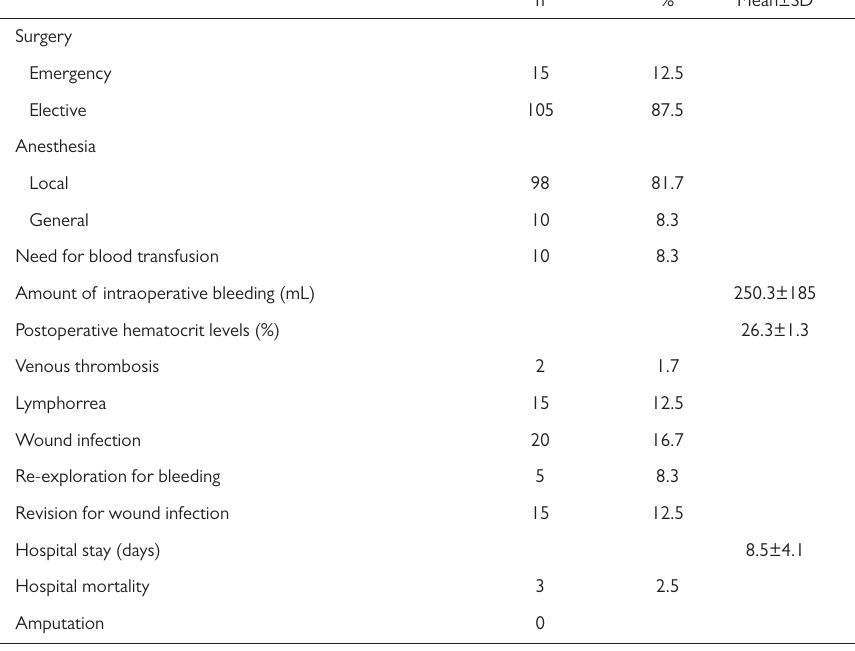
Table 2. Intraoperative parameters and postoperative early outcome of the